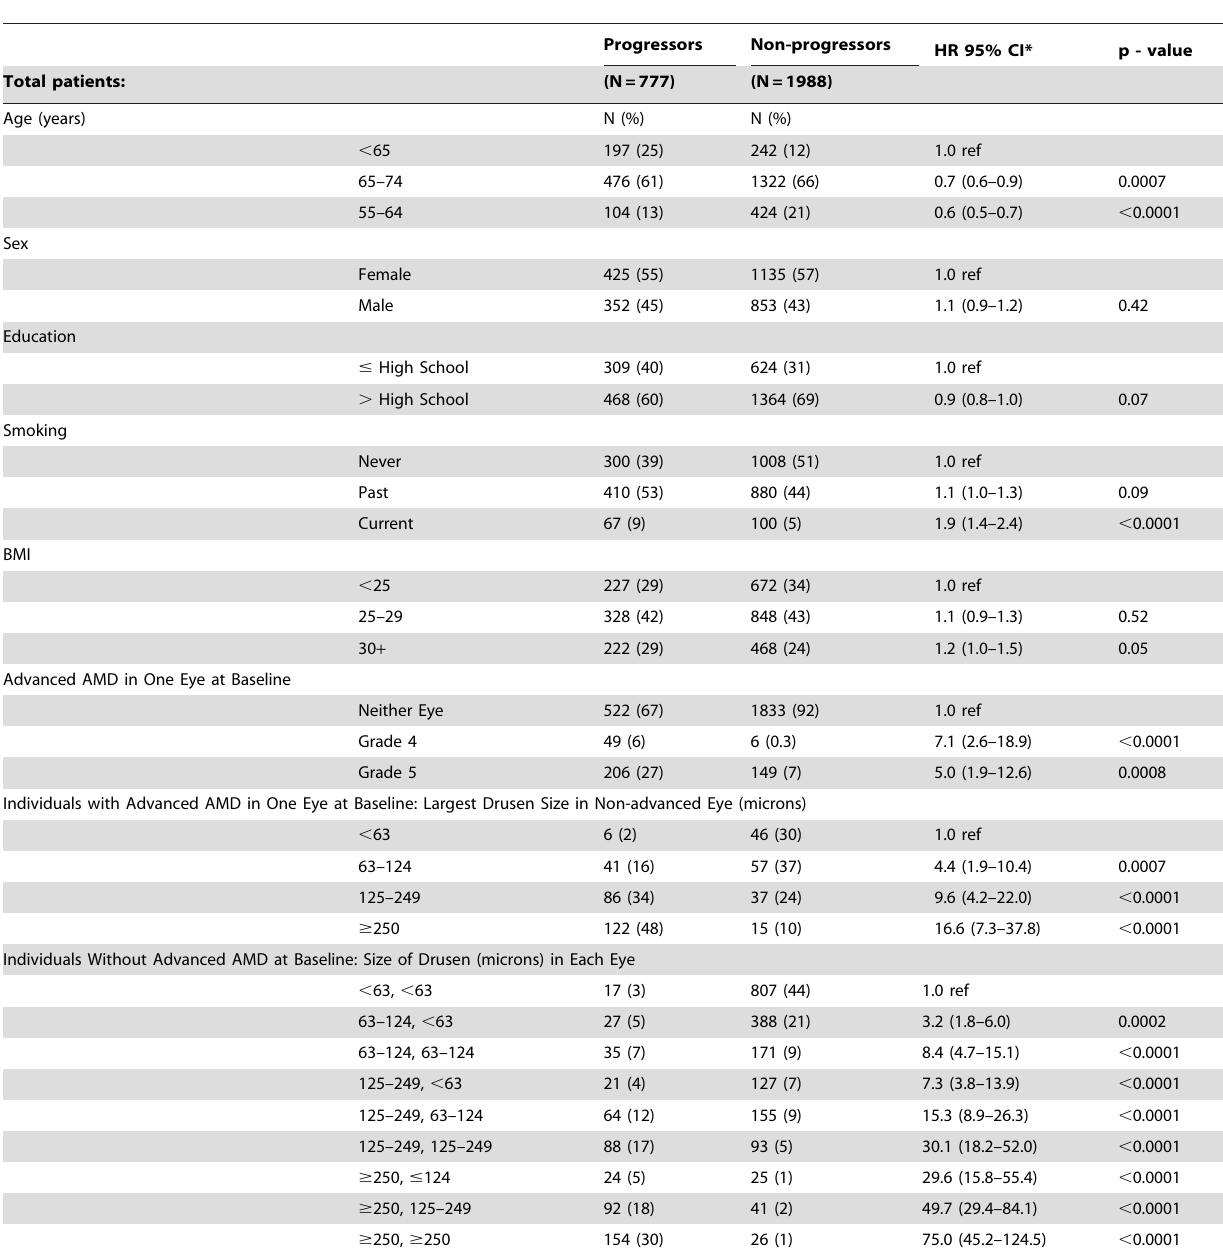
Table 1. Multivariate Associations between Baseline Demographic, Environmental, Macular Variables and Incidence of Advanced